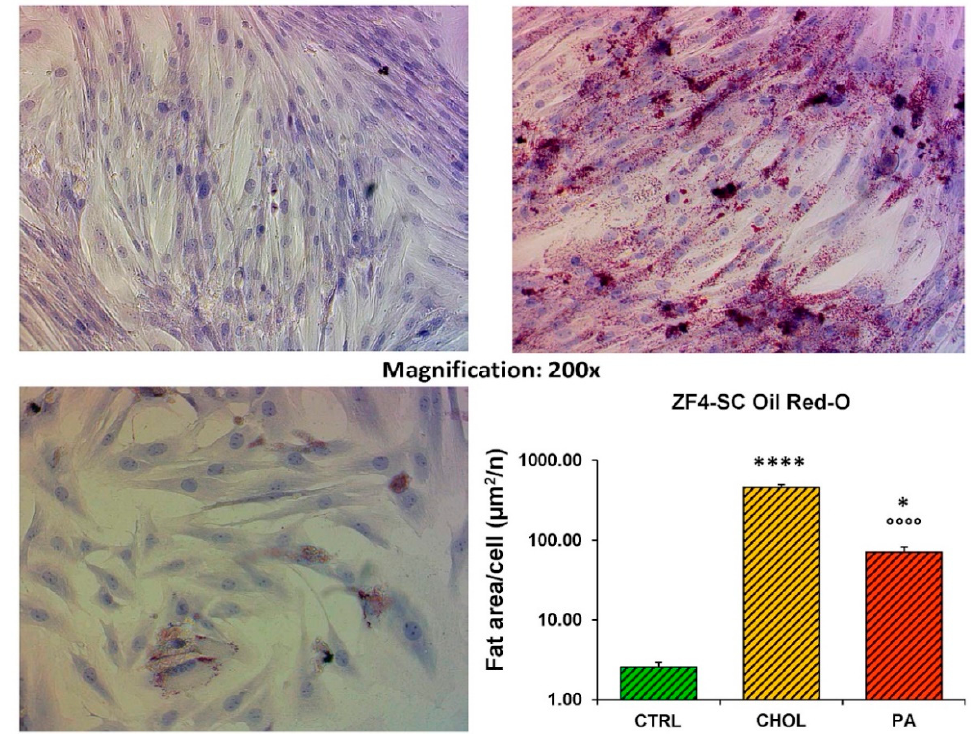
Figure 4. The ZF4-SC were similarly affected as ZL4-SC in the level of fat infiltration by both cholesterol and Na palmitate. For description see legend to Figure 3. **** p < 0.0001 (CHOL vs. CTRL); ◦◦◦◦ p < 0.0001 (PA vs. CHOL); * p < 0.05 (PA vs. CTRL).